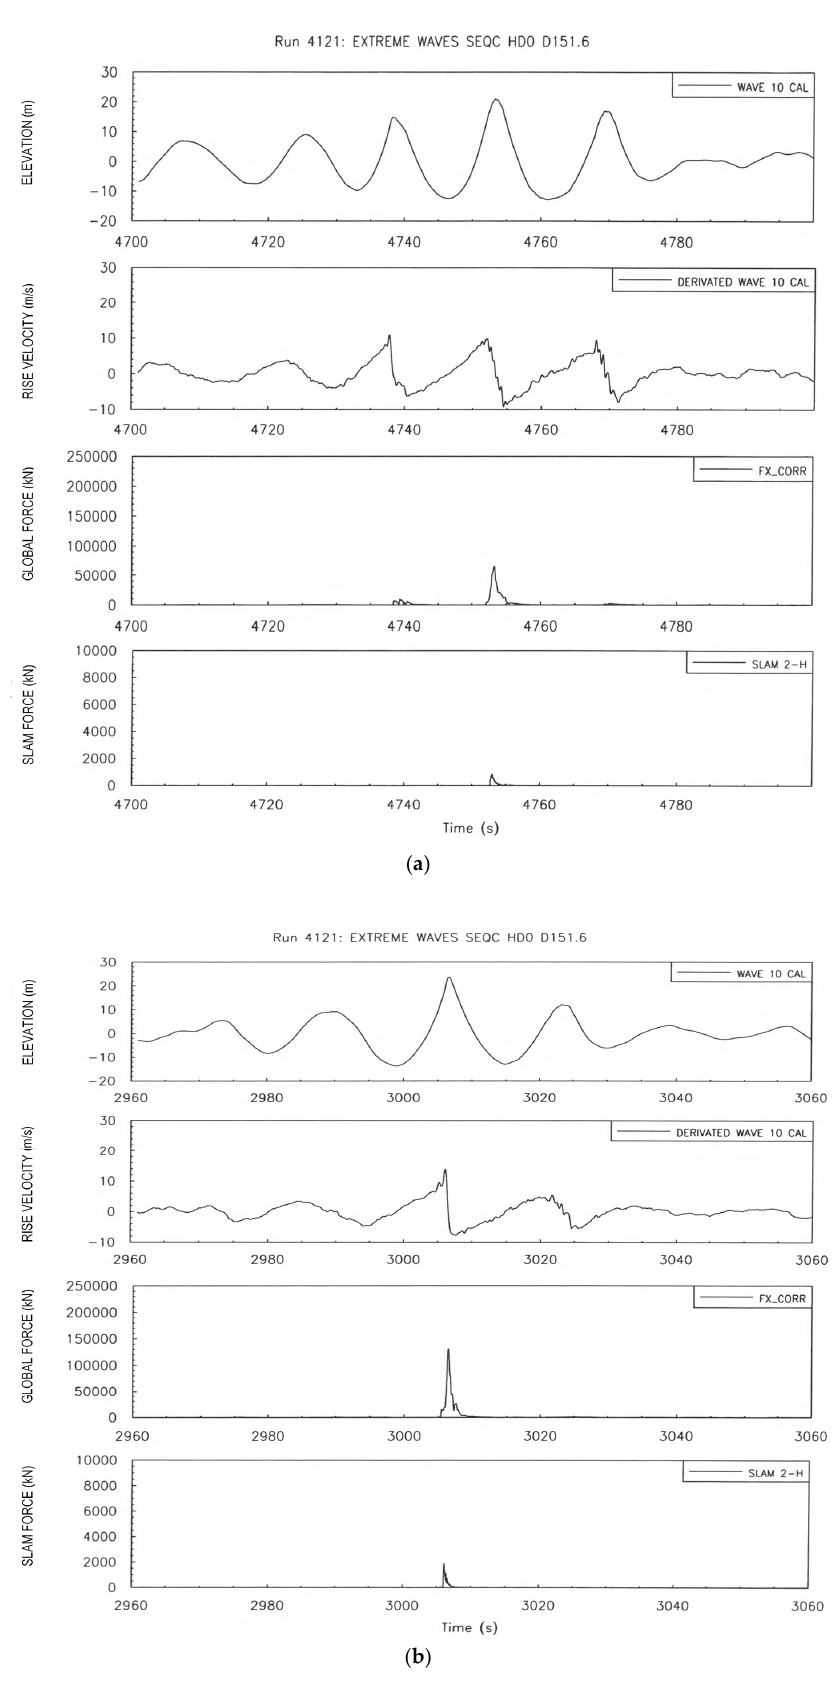
Figure 11. The same as Figure 10, but for two irregular wave events ( a , b ).